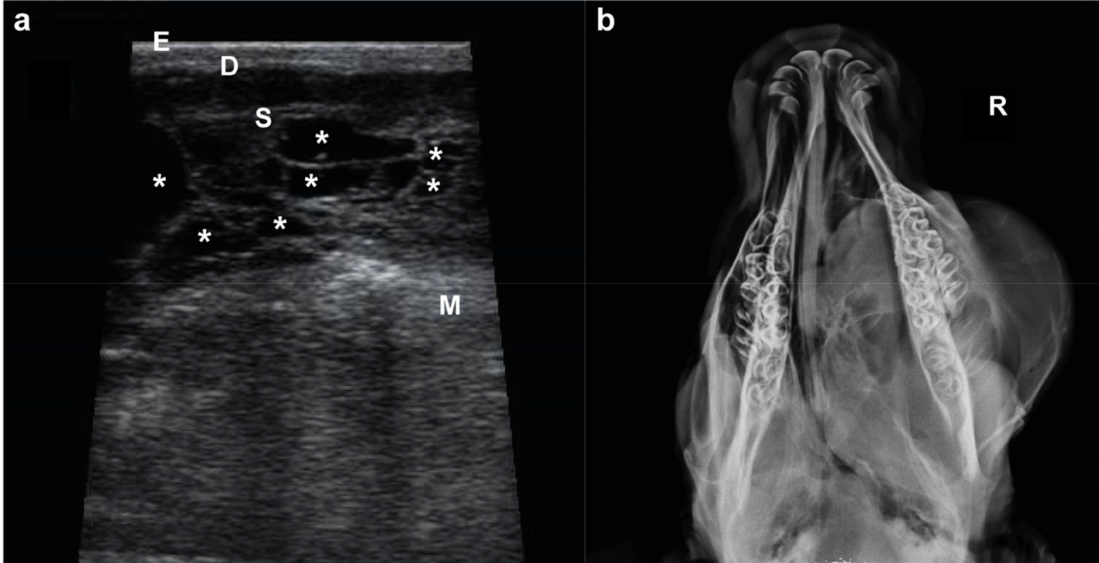
Figure 2. Imaging of the suborbital mass. ( a ) US image showing the three superficial layers (E, epidermis; D, dermis; S, subcutaneous tissue) overlying the malaris muscle (M) (note the bright hyperechoic appearance) and the mass with an irregular shape and multicavitary (*) (note the septated cavities filled with an anechogenic content) delimitated by S and M. ( b ) Radiography of the head in a dorso-ventral view (note that the mass extends to the left side of the hard palate). R, right